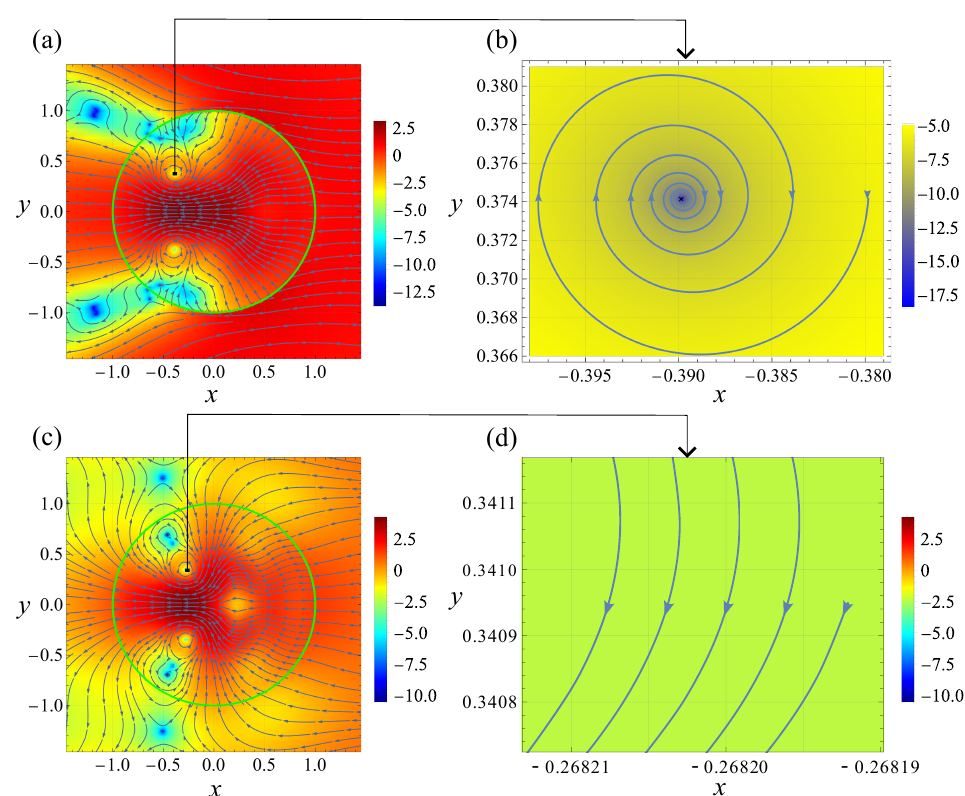
Figure 3. The same as that in Figure 2 but at λ = λ 2 = 1494 nm; ε ( λ 2 ) ≈ 17.983 + i 0.483. Table 2. Coordinates of singularities.